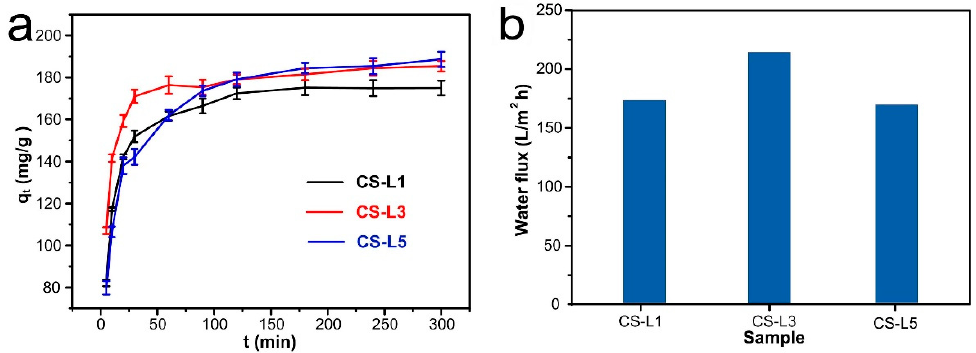
Figure 6. Effect of adsorption time on adsorption ability ( a ) and water flux ( b ) of CS membranes.